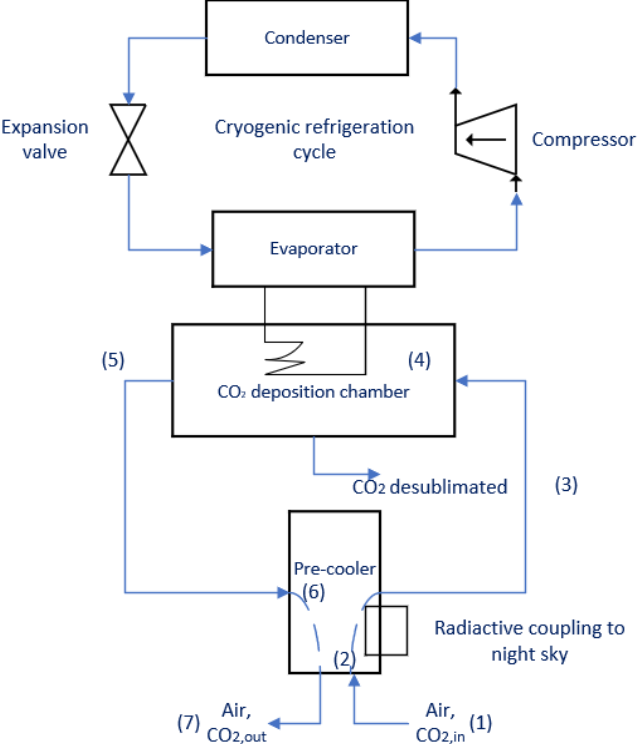
Figure 13. CO 2 cryogenic separation process scheme. Adapted from [25] .